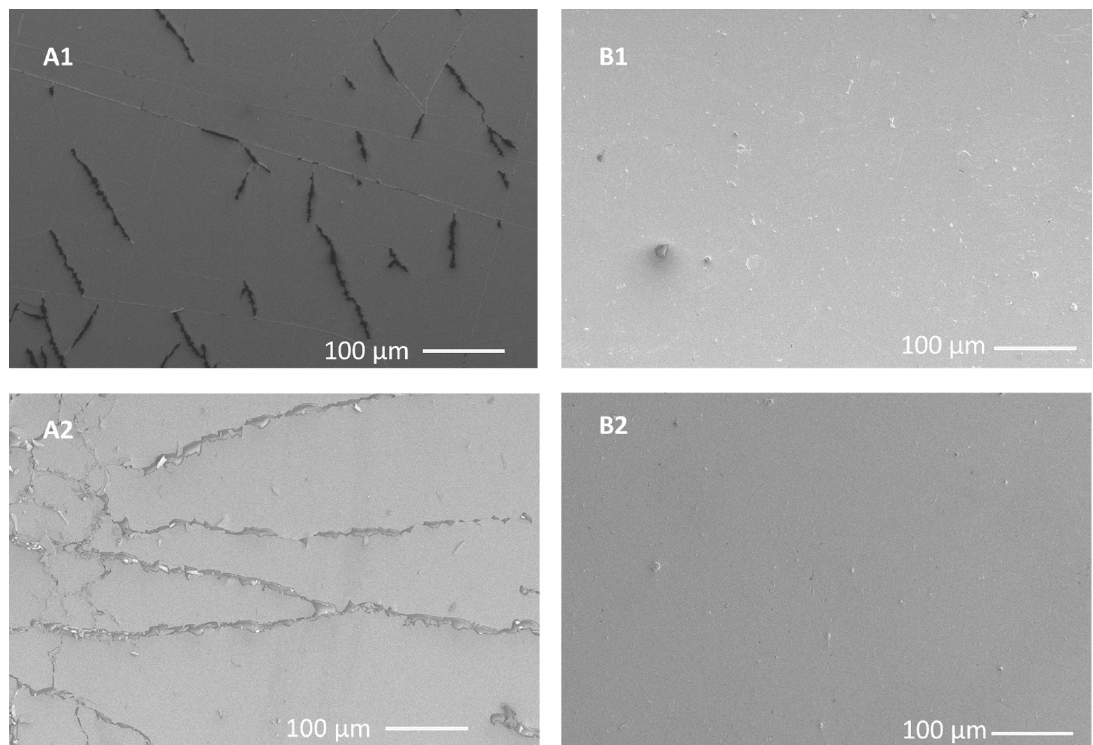
Figure 3. Micrographs (obtained by SEM) of AZO/PET films deposited by RF and PMS, with target-substrate distances of 5 and 4 cm. For the films deposited using RF, the presence of cracks is evident, which affects the adhesion to the substrate and the electrical conductivity of the AZO